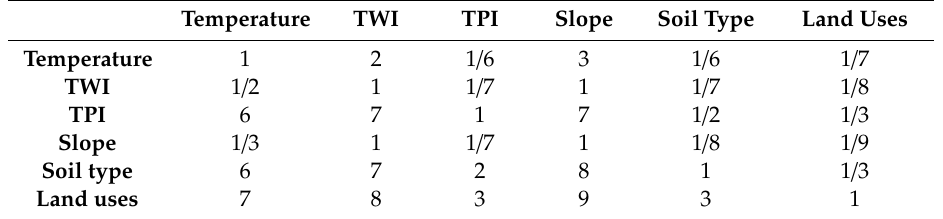
Table 1. Example of the analytical hierarchy process (AHP) pairwise comparison using the Saaty scale. Temperature TWI TPI Slope Soil Type Land Uses Temperature